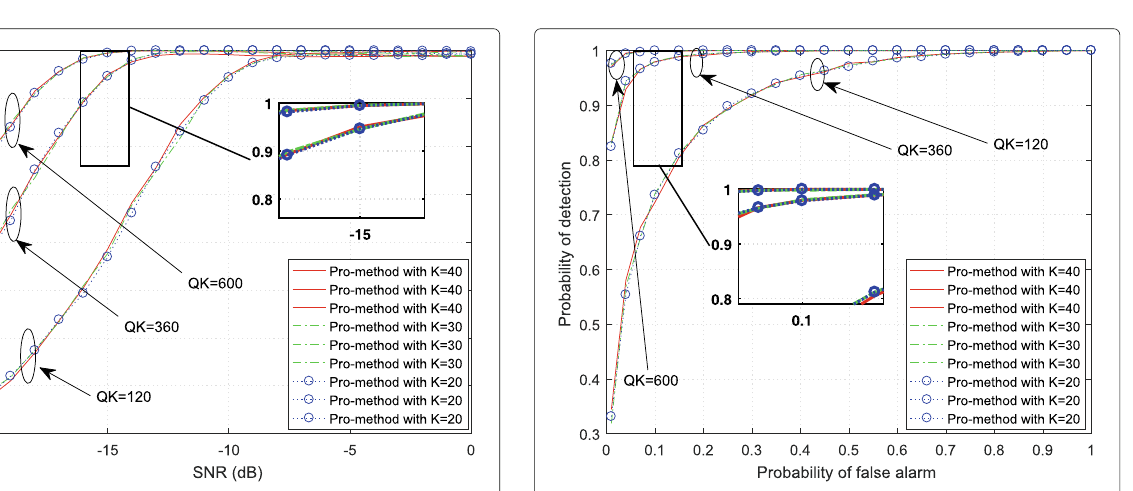
Fig. 6 Probability of detection versus SNR for the proposed method with QK = 600,360,120 and K = 40,30,20